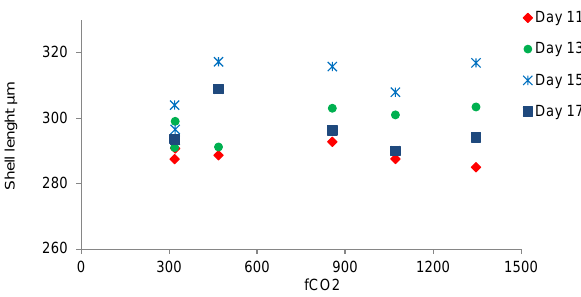
Figure 4. Sizes of the settled individuals exposed to different f CO 2 levels on days 11, 13, 15 and 17. Data are presented as means, n = ca. 35 at each data point. For clarity, SE (standard error) is not